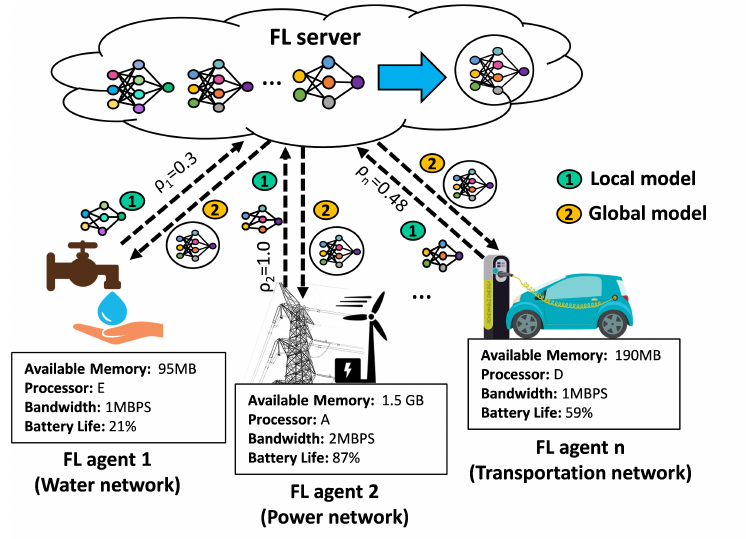
Figure 2. Allowing partial amounts of work from the FL